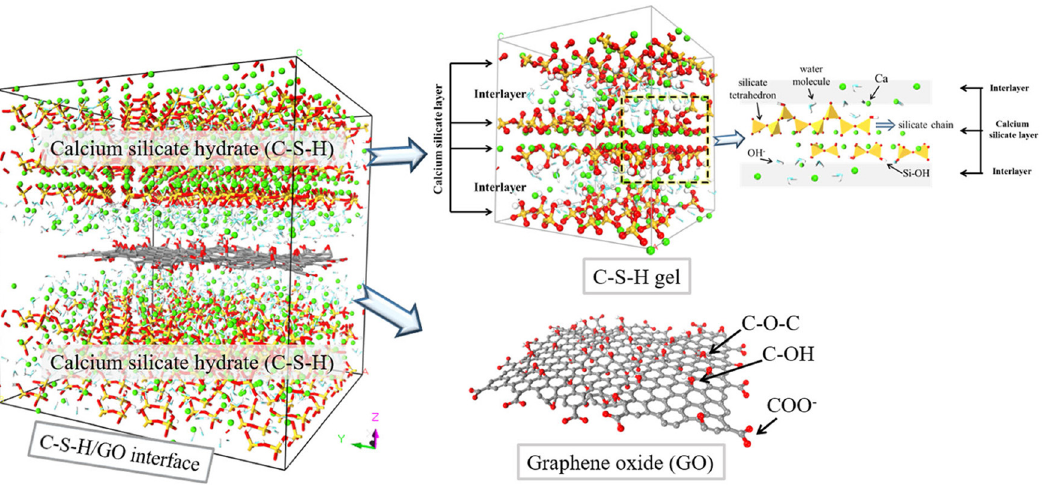
Figure 8: Model of in fl uence of GO on C – S – H gel [ 84 ]